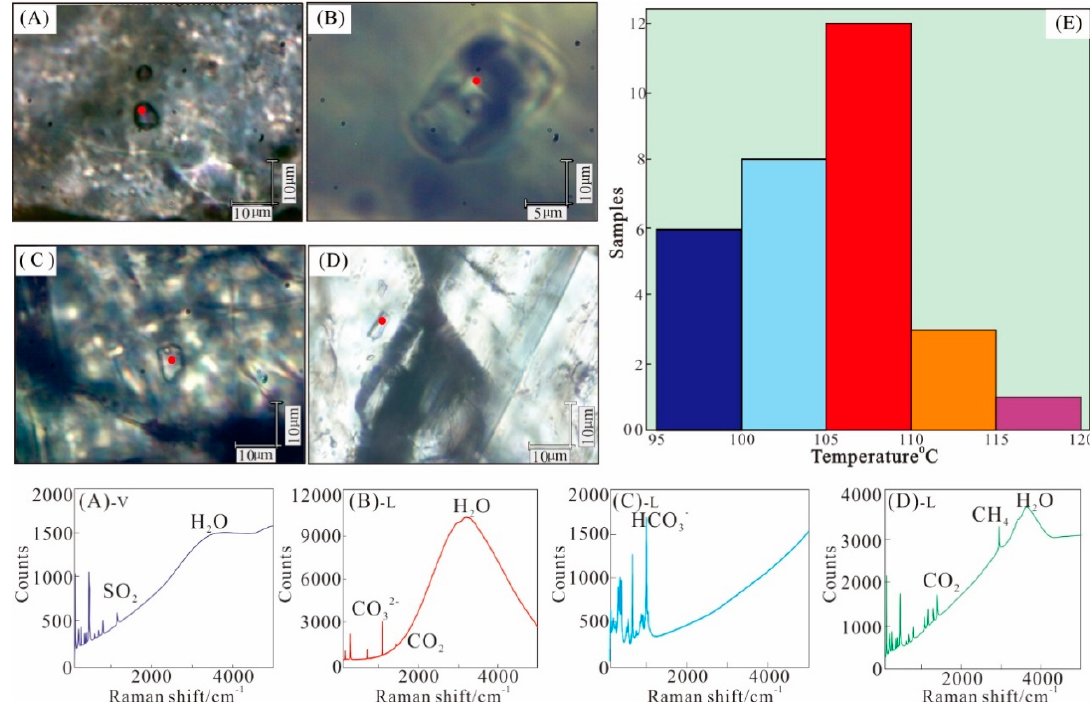
Figure 6. Inclusions and Laser Raman spectrum characteristics of contained in quartz veins ( A ) and calcite veins ( B – D ) and frequency histogram of fluid inclusion homogenization temperature ( E ). Abscissa is Raman shift in the unit of cm − 1 , and ordinate is Raman scattering relative strength in the unit of count/second (L, liquid phase; V, gas phase).